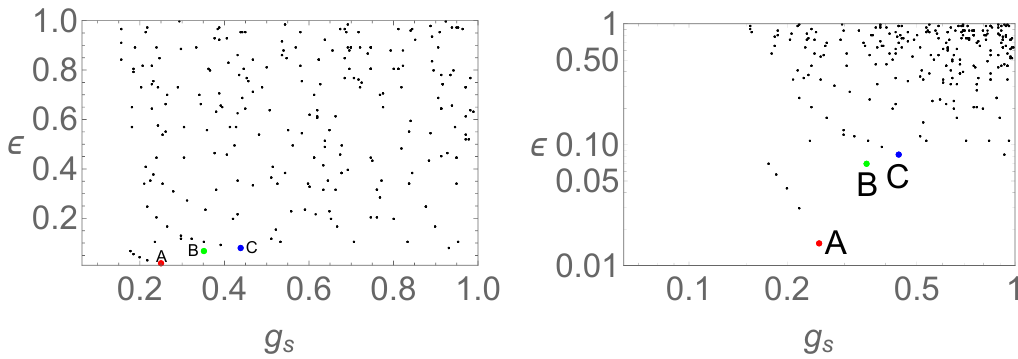
Figure 1 . Numerical results for the distribution of (cid:13)ux vacua with nonzero vacuum energy. Each dot corresponds to a solution with di(cid:11)erent set of (cid:13)uxes. Note that, however, generically these dots can be degenerated in this 2D plot, due to the existence of another direction of the stabilized moduli (cid:28) which is not depicted here for the simplicity. The right (cid:12)gure represents the log-log plot of the same set of